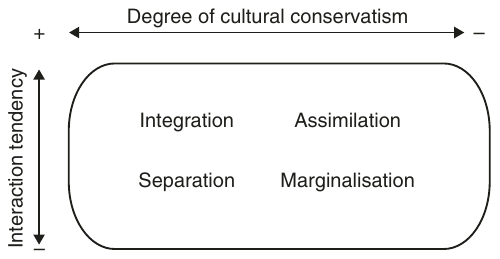
Fig. 1 Berry ’ s classi fi cation of acculturation orientations 5 . The four acculturation orientations result from the two dimensions shown on the axes: how much importance individuals give to maintaining their own cultural identity ( ‘ degree of cultural conservatism ’ , horizontal axis) and